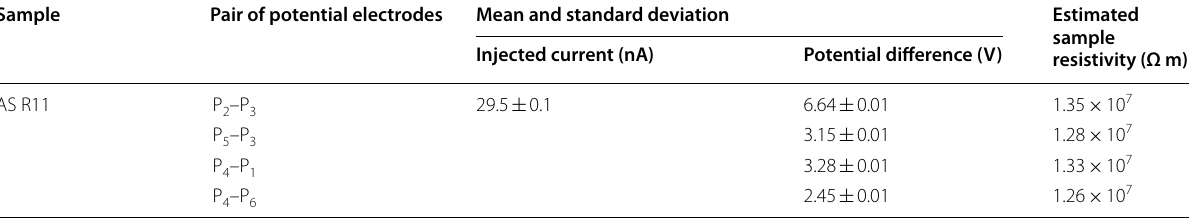
Table 7 Measurement results for the high-resistivity plastic sample (AS R11)